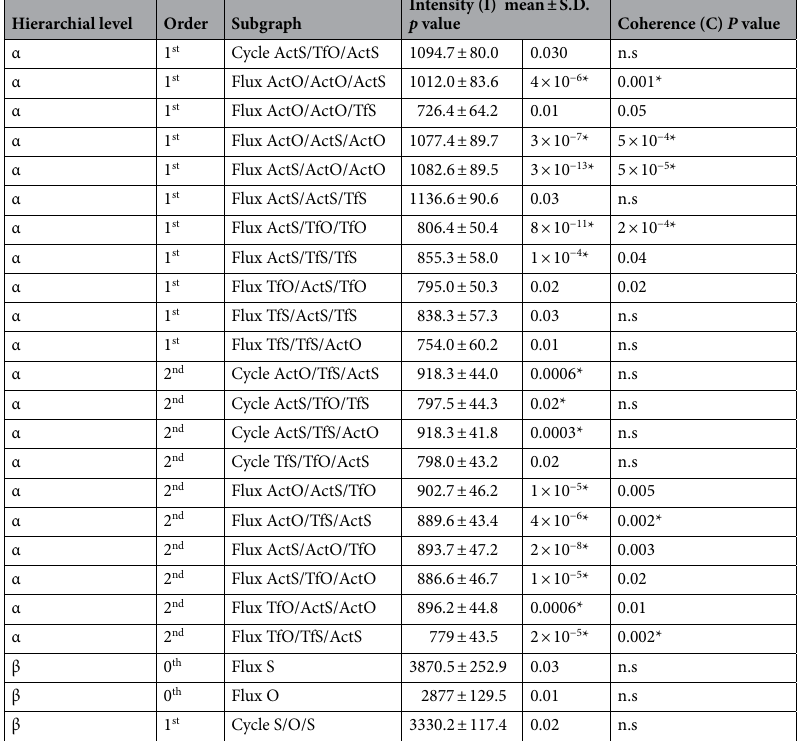
Table 5. Intensity and Coherence values of Subgraphs at different hierarchical levels. Asterisks on the p values indicate significance after Bonferroni correction—see the text for